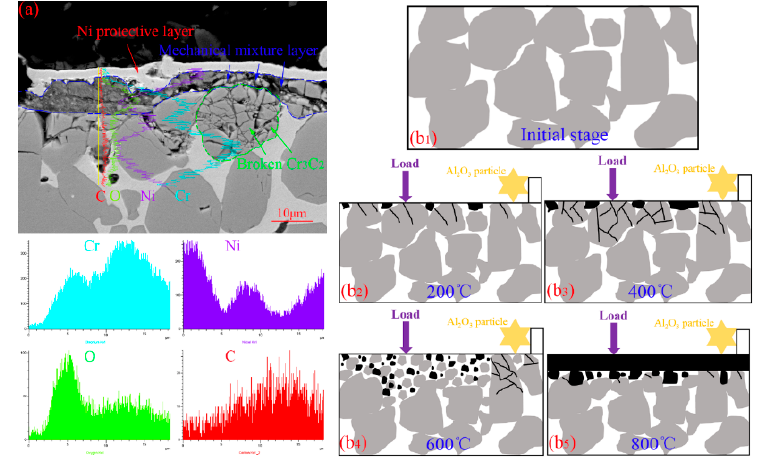
Figure 6. ( a ) SEM morphology and EDS results of the wear vertical cross section for the specimen without Mo; and ( b1–b5 ) Schematic illustration of the wear mechanism.